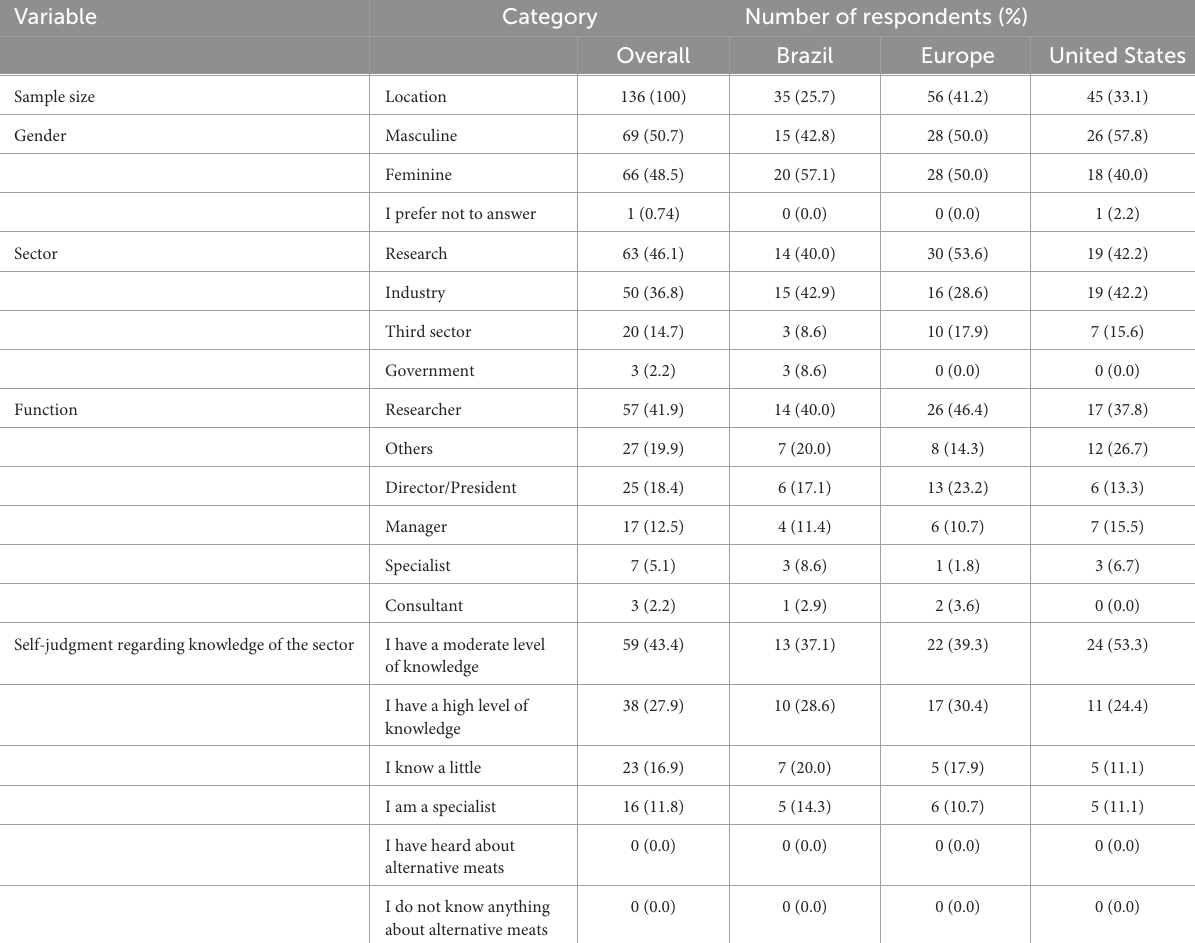
TABLE 1 Demographic data of the analyzed sample, as per on-line interviews from August to October, 2021.